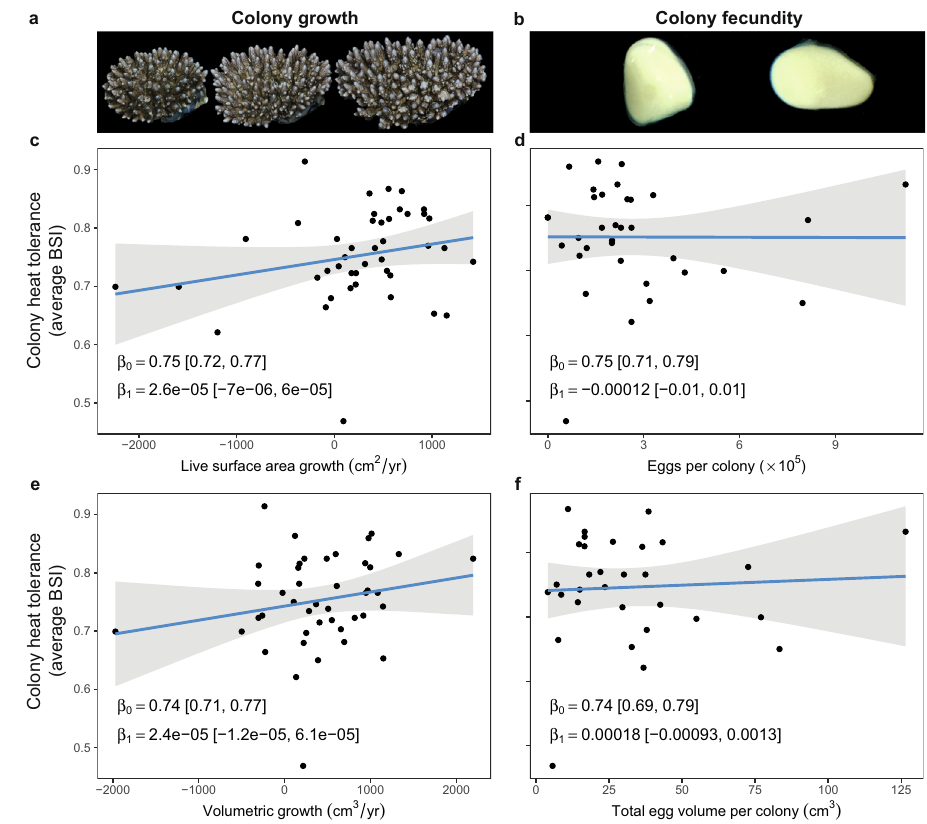
Fig. 2 No apparent trait trade-offs associated with overall coral colony heat tolerance. Associations between colony heat tolerance (average BSI through time) and either corrected growth metrics ( c – live surface area growth, and e – volumetric growth) or colony fecundity ( d – eggs per colony, and f – total egg volume per colony). Example 3D models used to measure growth are shown for a single colony ( a ), and microscope images of eggs which were counted and measured to determine fecundity are also shown ( b ). Each plot shows the median and 95% credible interval of intercept ( β 0 ) and slope ( β 1 ) parameters of linear regressions, where a negative slope would re fl ect a trade-off, however weak positive associations are present for growth ( c , e